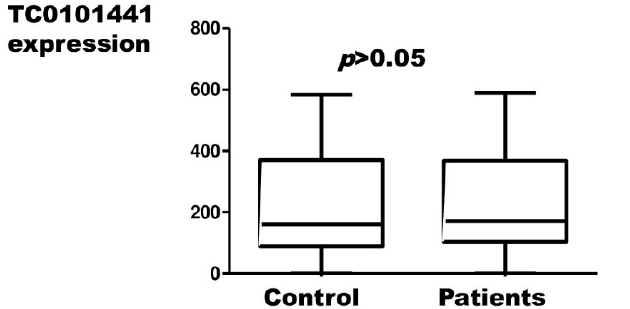
Figure 4. Relative expression of the TC0101441 in endometriosis patients with respect to the control material (Mann–Whitney test; p > 0.05).